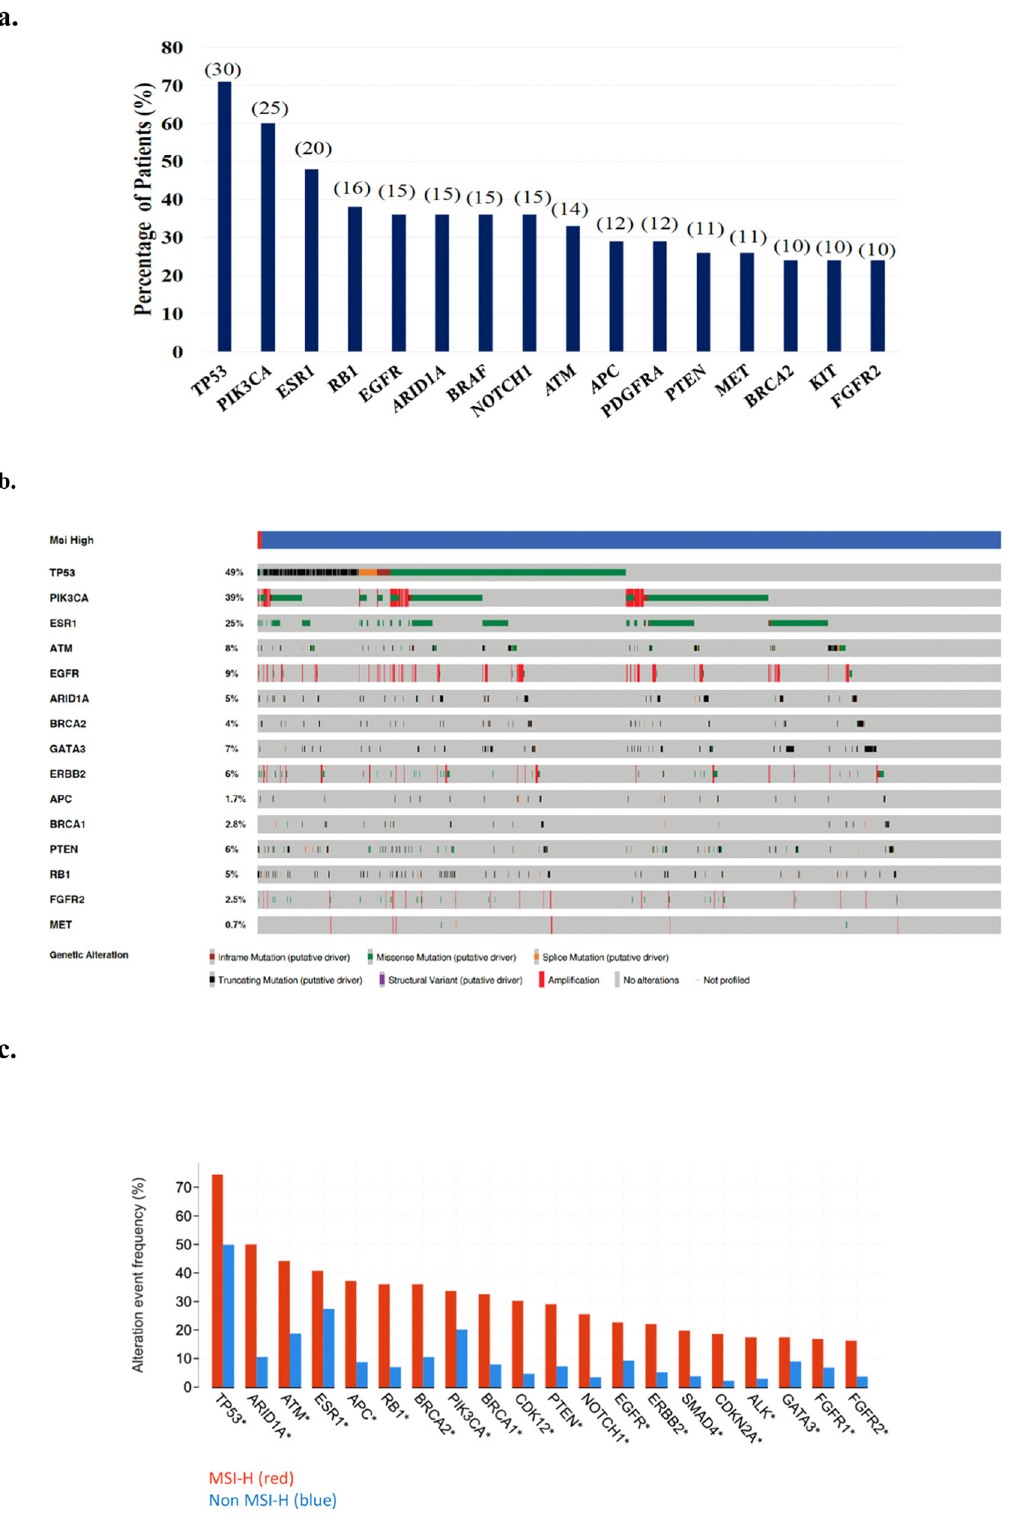
Fig. 2 Analysis of co-existing gene mutations. a Most common non-synonymous variants seen in MSI-H patients with ≥ 1 cfDNA alteration detected. Absolute number of patients are indicated in (#). b Comparison of 15 most frequent gene mutations (excluding VUS and synonymous variants) in MSI-H samples (red) and non-MSI-H samples (blue). c Differences in the frequency of genes (excluding synonymous variants, but including VUS) in MSI-H (red) vs non-MSI-H (blue) samples (* indicating signi fi cant differences, p < 0.05 one-sided Fisher exact test) of the top 20 signi fi cantly mutated genes between